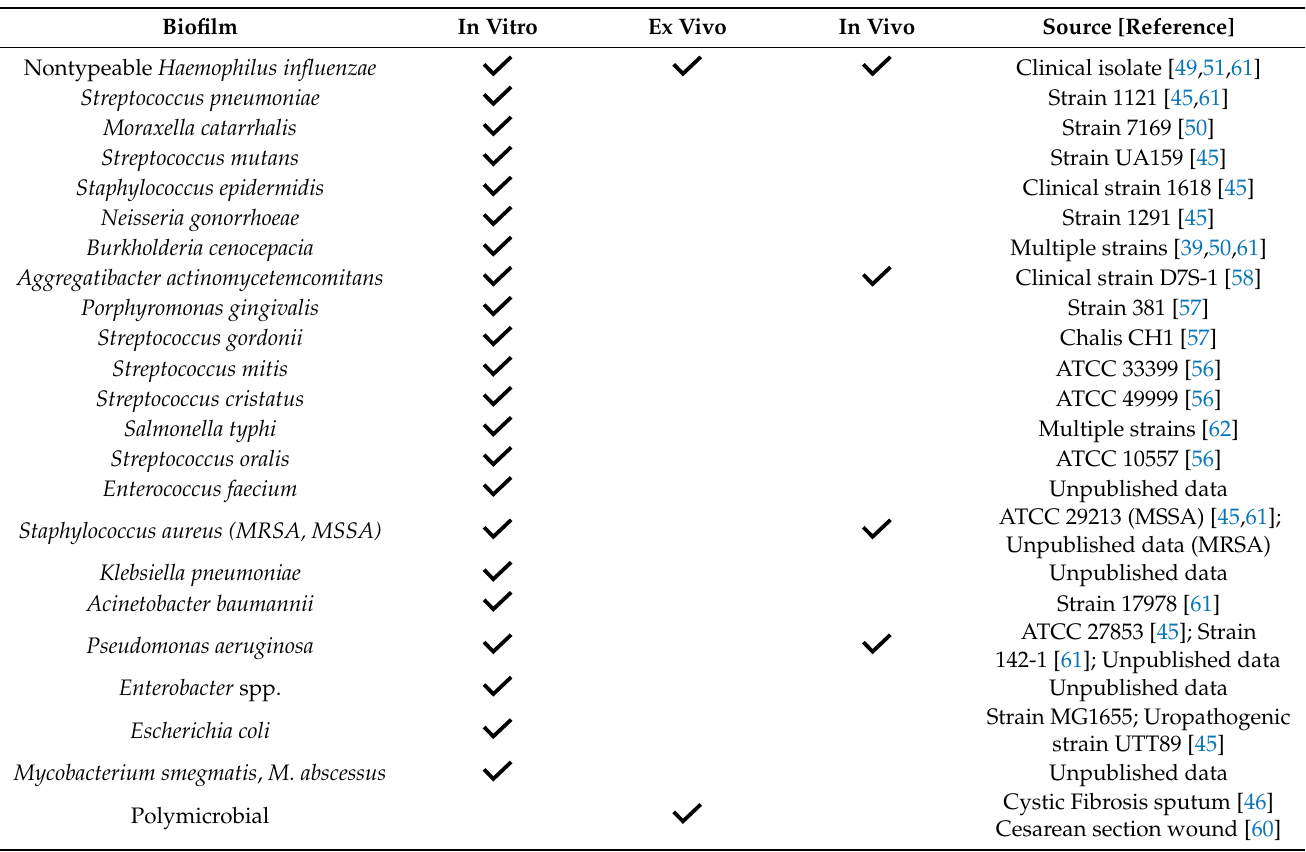
Table 2. Bacterial species and strains tested to date in either in vitro, ex vivo, or in vivo models, including ESKAPEE bacteria ( E. faecium, S. aureus, K. pneumoniae, A. baumannii, P. aeruginosa, Enterobacter spp. , and E. coli ).